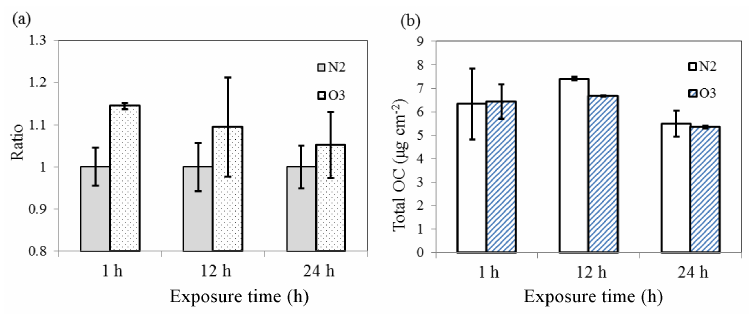
Figure 7. (a) Relative DTT t for NSOA after O 3 and N 2 exposure. For each of the exposure duration (1, 12, 24h), the DTT t of O 3 exposure group was normalized by the DTT t of the corresponding N 2 exposure group. Generally, DTT t of NSOA that underwent heterogeneous ozonolysis was higher than that of the N 2 control. (b) OC / EC measurement results show total OC mass loss (17 and 13% for O 3 and N 2 exposure, respectively) after 24h exposures. Each measurement was conducted in triplicates, and the error bar represents the SEM.